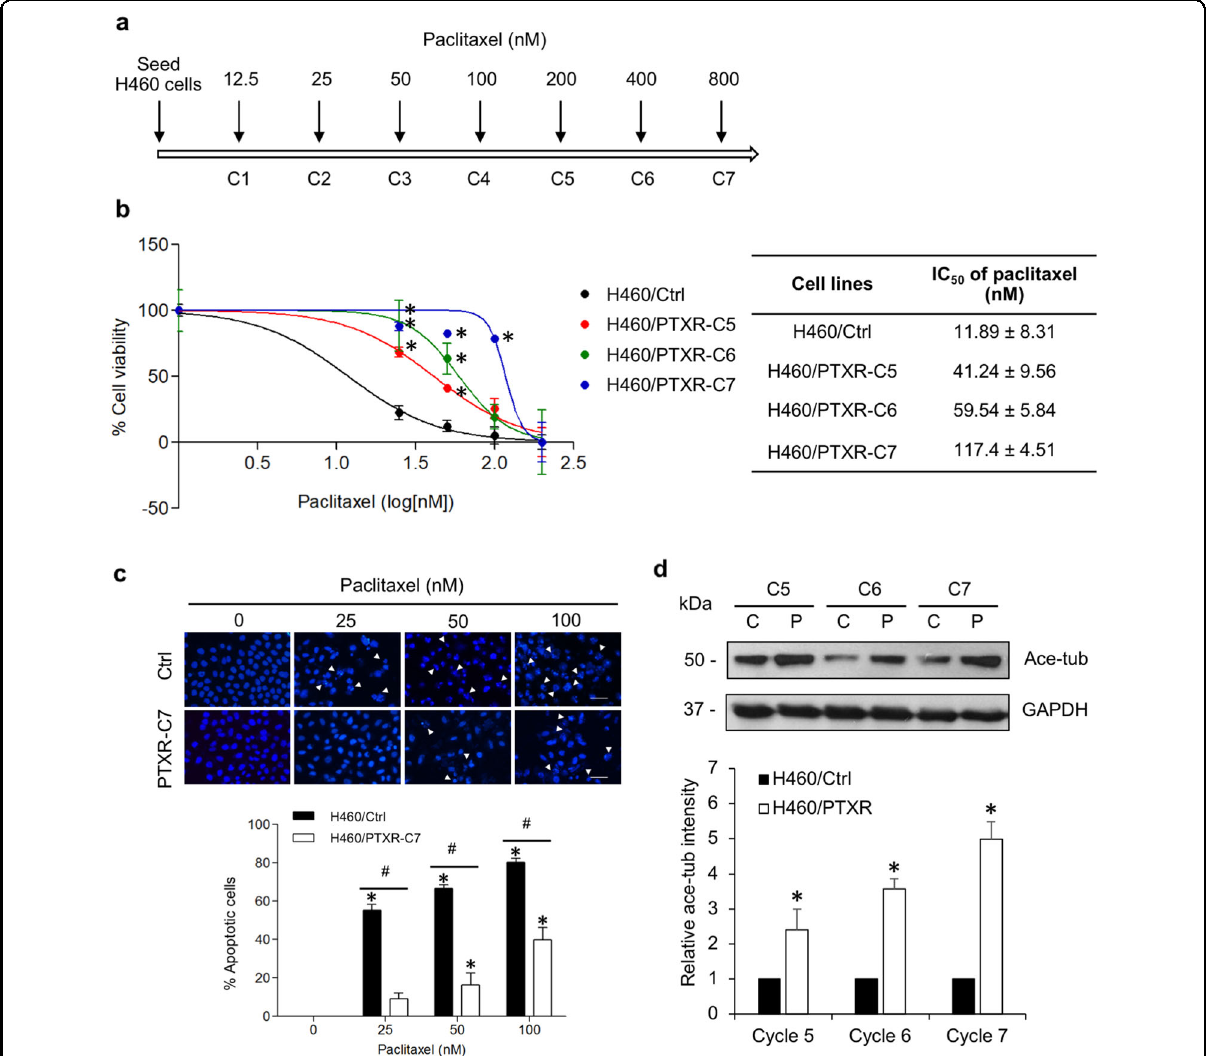
Fig. 3 Tubulin acetylation is upregulated in paclitaxel-resistant cells. a Scheme demonstrating the time course of paclitaxel-resistant cell establishment. b Paclitaxel-resistant H460 (H460/PTXR) cells at cycles 5, 6, and 7 and their passage-matched control H460 (H460/Ctrl) cells were treated with paclitaxel (0 – 200 nM) for 48 h. Cell viability was analyzed by MTT assay. The graph shows the cell viability (%) as the mean ± SEM ( n = 3). Student ’ s t test, * P < 0.05 vs H460/Ctrl cells. The table shows the IC 50 of paclitaxel ± SEM in paclitaxel-resistant (H460/PTXR) and control (H460/Ctrl) cells. c Paclitaxel-resistant H460 cells at cycle 7 (H460/PTXR-C7) and control H460 (H460/Ctrl) cells were treated with paclitaxel (0 – 100 nM) for 48 h. Apoptotic nuclei (white arrowheads) were imaged by fl uorescence microscopy. Scale bars: 50 μ m. The graph represents the percentage of apoptotic cells as the mean ± SEM ( n = 3). Student ’ s t test, * P < 0.05 vs nontreated cells; # P < 0.05 vs passage-matched control H460 (H460/Ctrl) cells. d Acetylated tubulin (Ace-tub) expression in paclitaxel-resistant (H460/PTRX, P) and control (H460/Ctrl, C) cells was examined by western blot analysis. The blots were reprobed with GAPDH to con fi rm equal loading. The graph shows the mean ± SEM of the relative Ace-tub intensity. Student ’ s t